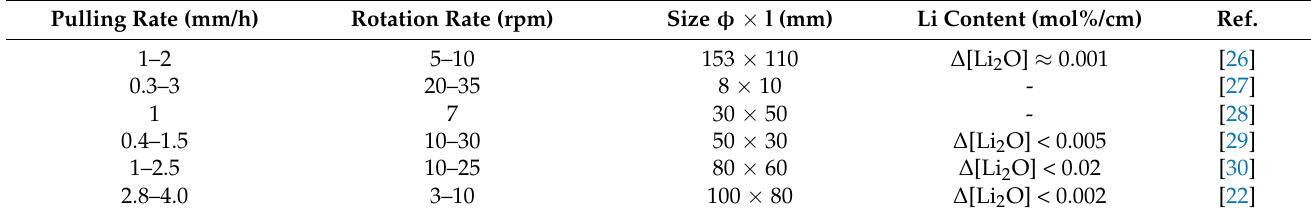
Table 1. Growth parameters of LiNbO 3 reported in literatures.